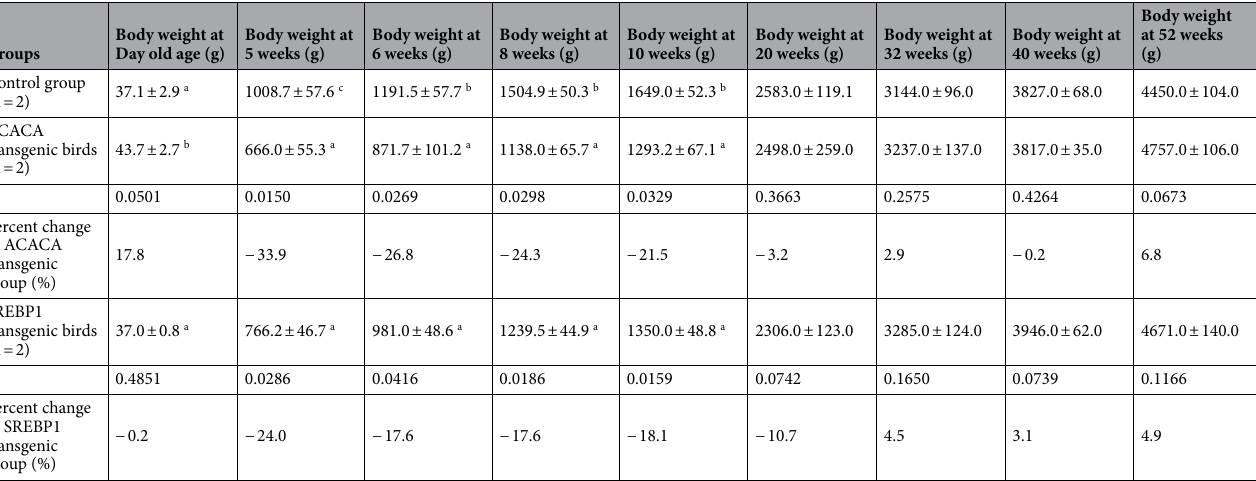
Table 3. Growth performance (Mean ± standard deviation) of female transgenic and control birds during 1st generation. Different superscripts (column-wise) indicate significant differences. Body weights of all the experimental birds were measured in the electronic weighing balance at day old, 5, 6, 8, 10, 20, 32, 40 and 52 week of age. Body weights were compared between ACACA transgenic and control group, and SREBP1 transgenic and control group to determine the effect of knock down on body weights in transgenic chicken.